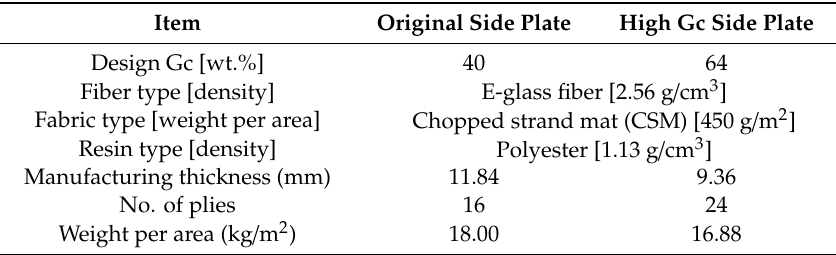
Figure 6. Detailed comparison of 40 and 64 wt.% Gc specimens. Table 3. Dimensions of specimens taken from designed hull plate with Gc of 40 wt.%. Sample